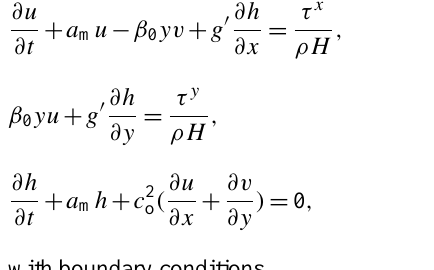
Fig. 1. Schematic representation of the Zebiak-Cane model show- ing the shallow-water layer with embedded surface mixed layer in the ocean. The shallow-water layer is bounded below by the ther- mocline. Coupled to the ocean part there is the atmosphere model with horizontal velocities and geopotential